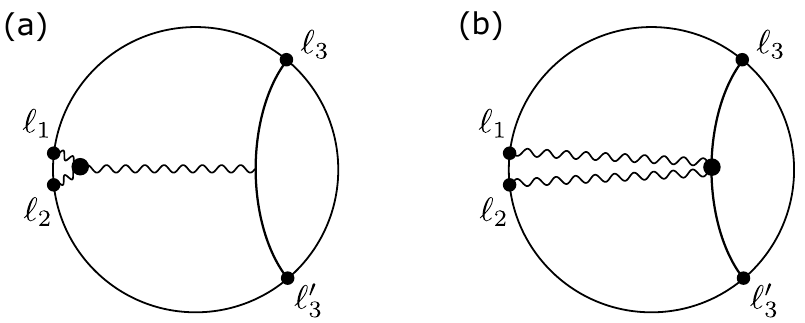
Figure 5 . Illustration of our radial locality criterion. In panel (a), we see an interaction that is not localized near the geodesic, i.e. that involves the fields Π Π arbitrarily far from it. In the limit 1 , 2 of nearby source points ‘ , this creates contributions with “short” propagators, which become 1 , ‘ 2 singular at ‘ = ‘ . In panel (b), we see an interaction that is localized near the geodesic. The 1 2 propagators from ‘ are now “long”, and the ‘ = ‘ limit has no 1 , ‘ 2 1 2